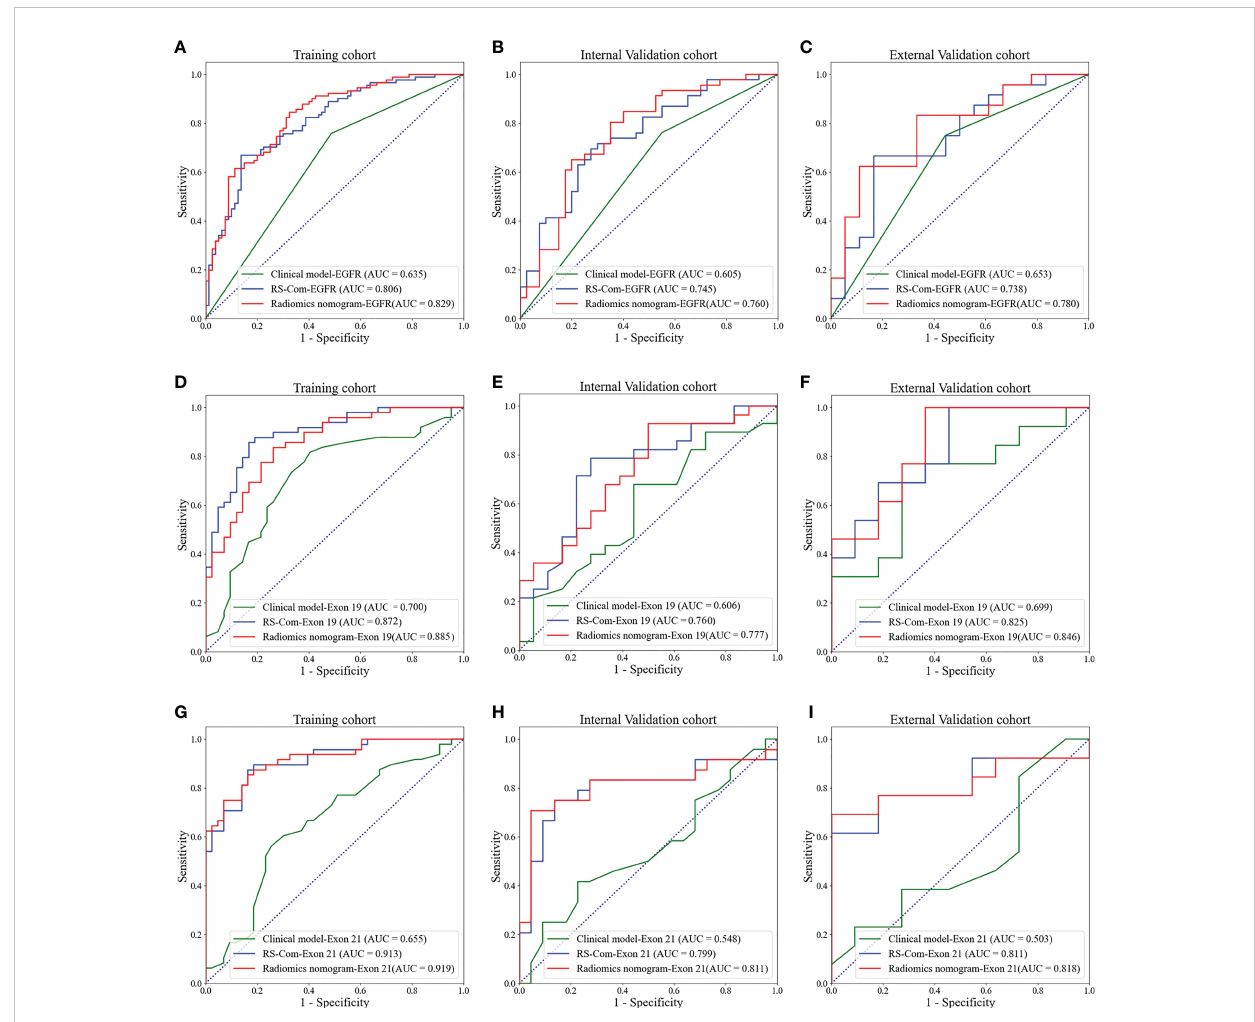
FIGURE 5 ROC curves for predicting the EGFR mutations and subtypes. (A – C) , ROC curves of the models for predicting the EGFR mutation in the training (A) , internal validation (B) and external validation (C) cohorts. (D – F) , ROC curves of the models for predicting the EGFR mutation in exon 19 in the training (D) , internal validation (E) and external validation (F) cohorts. (G – I) , ROC curves of the models for predicting the EGFR mutation in exon 21 in the training (G) , internal validation (H) and external validation (I) cohorts.